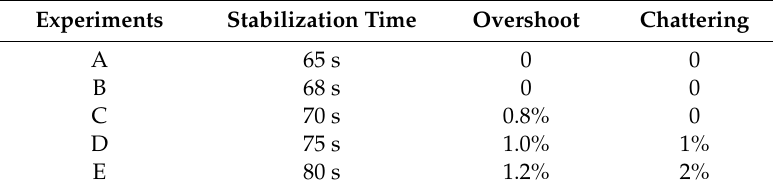
Table 2. The control performance indicators of the intelligent control algorithm of the